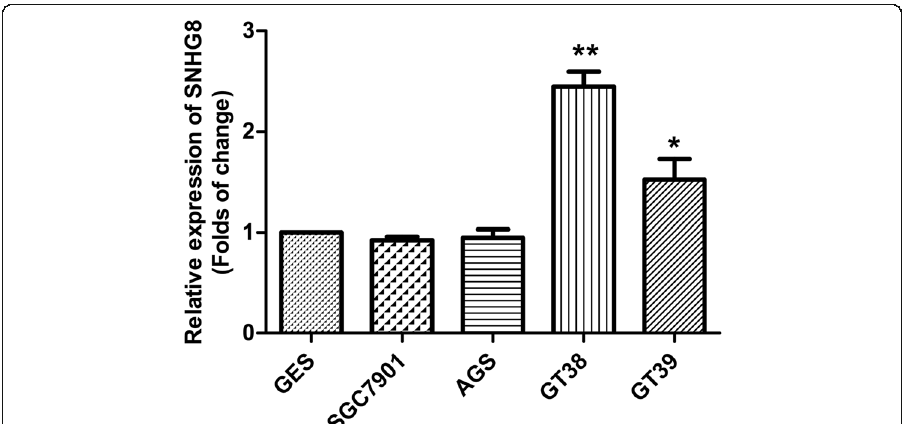
Fig. 1 LncRNA SNHG8 expression was upregulated in EBV-associated GC cells. The relative SNHG8 levels are shown for normal human gastric mucosal cell line GES-1, EBV-negative GC cell lines SGC7901 and AGS, EBV- associated GC cell lines GT38 and GT39. * p < 0.01 and ** p < 0.01 compared to